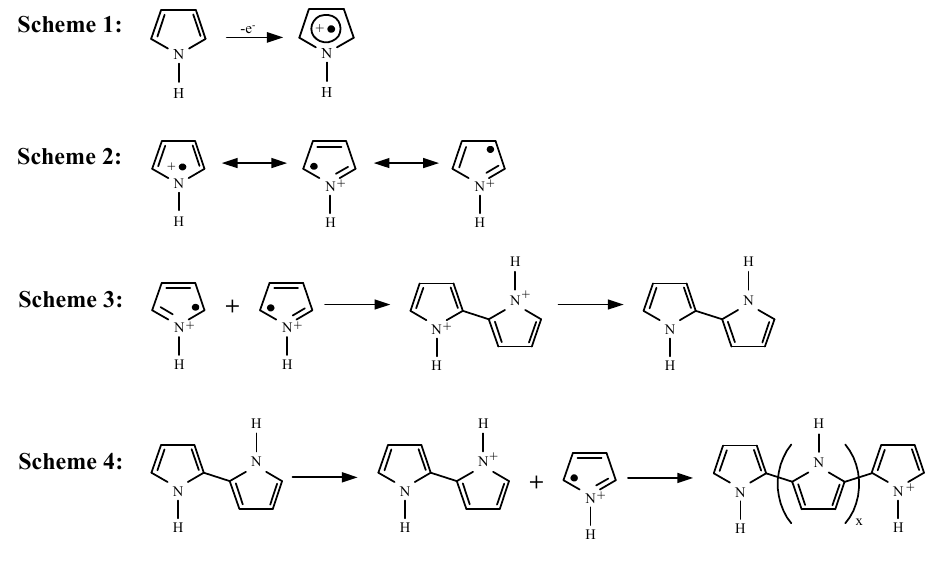
Figure 7. Pyrrole oligomerization pathway [37].